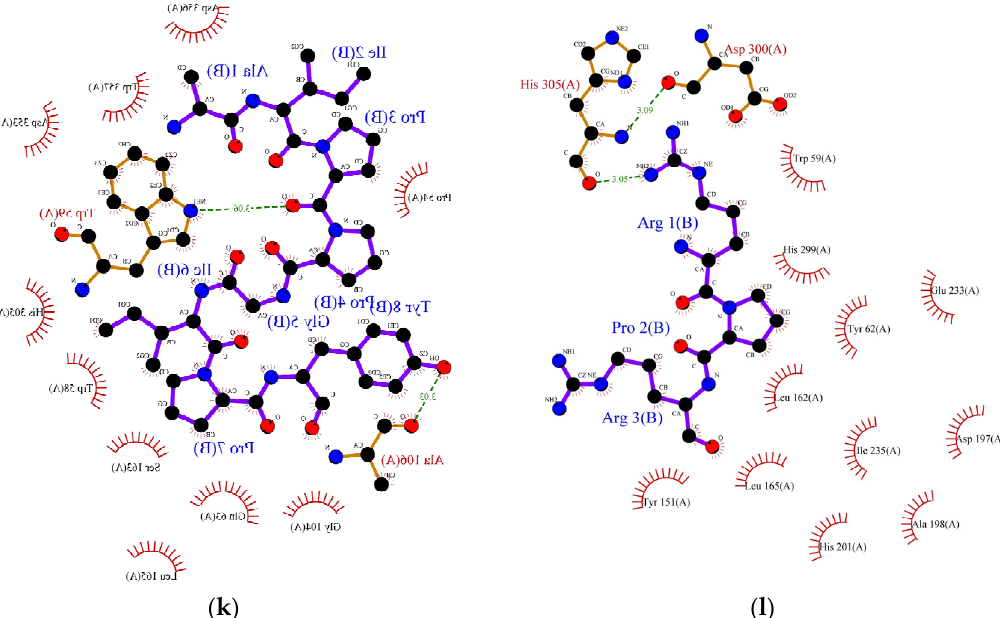
Figure 2. Protein ligand binding interaction between ( a ) RPR, ( b ) LRP, ( c ) RR, ( d ) SPRRF, ( e ) FE, and ( f ) PPGIP and α -glucosidase enzyme as well as ( g ) ML, ( h ) LP, ( i ) MLLL, ( j ) SPRRF, ( k ) AIPPGIPY, and ( l ) RPR and α -amylase enzyme. The blue ball, nitrogen atom; yellow ball, sulphur atom; red ball, oxygen atom; black ball, carbon atom; purple line, peptide; green dotted line with a number, hydrogen bond, and length of bond; red eyelashes, hydrophobic